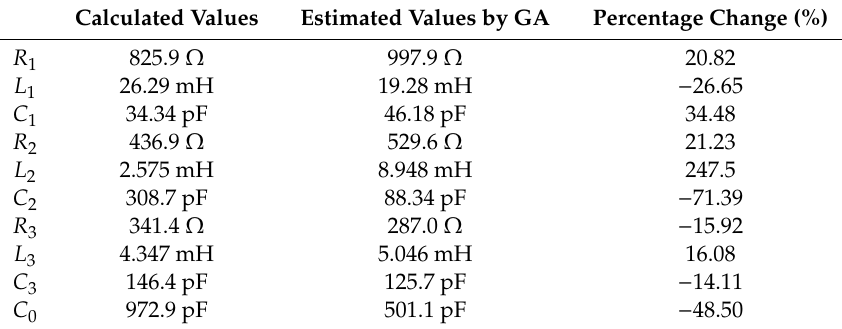
Table 1. Calculated and estimated equivalent parameters.